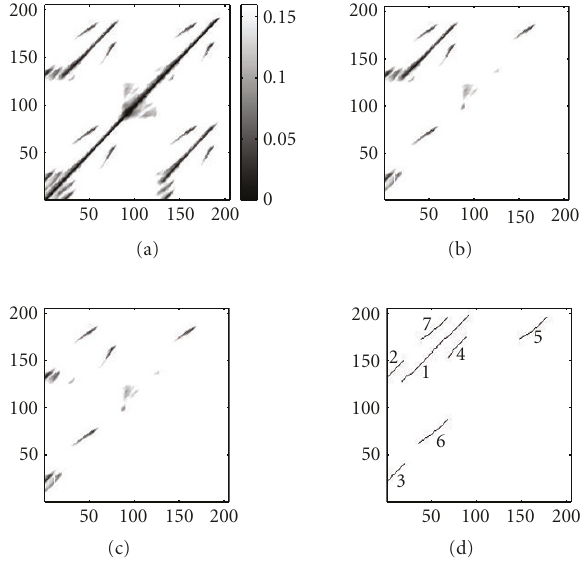
Figure 9: Illustration of the path extraction algorithm for the Brahms example of Figure 1. (a) Self-similarity matrix S = S min C = 0 . 16 are ad 16 [41,10]. Here, all values exceeding the threshold plotted in white. (b) Matrix S after step (0) (initialization). (c) Ma- trix S after performing steps (1) and (2) once using the thresholds C = 0 . 08 and C = 0 . 16. Note that a long path in the left upper in ad corner was constructed, the neighborhood of which has then been removed. (d) Resulting path set P = { P 1 , ... , P 7 } after the postpro- cessing of step (3) using K 0 = 5 and C pr = 0 . 10. The index m of P m is indicated along each respective